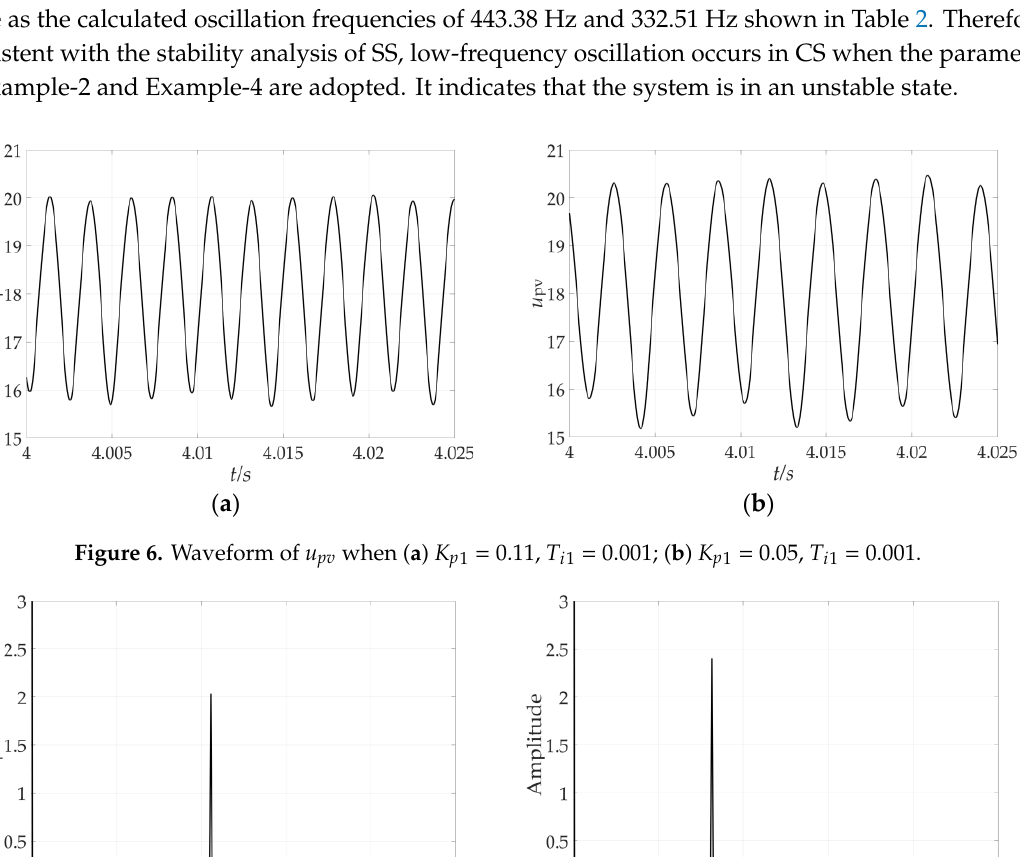
Figure 7. FFT spectrogram of u pv when ( a ) K p 1 = 0.11, T i 1 = 0.001; ( b ) K p 1 = 0.05, T i 1 = 0.001.